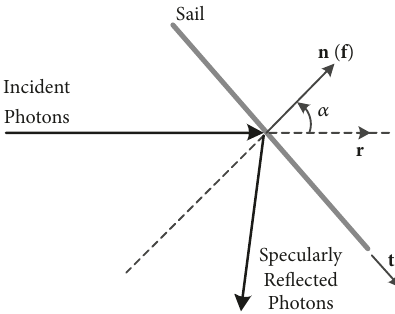
Figure 1: Solar-radiation-pressure force model of an ideal solar